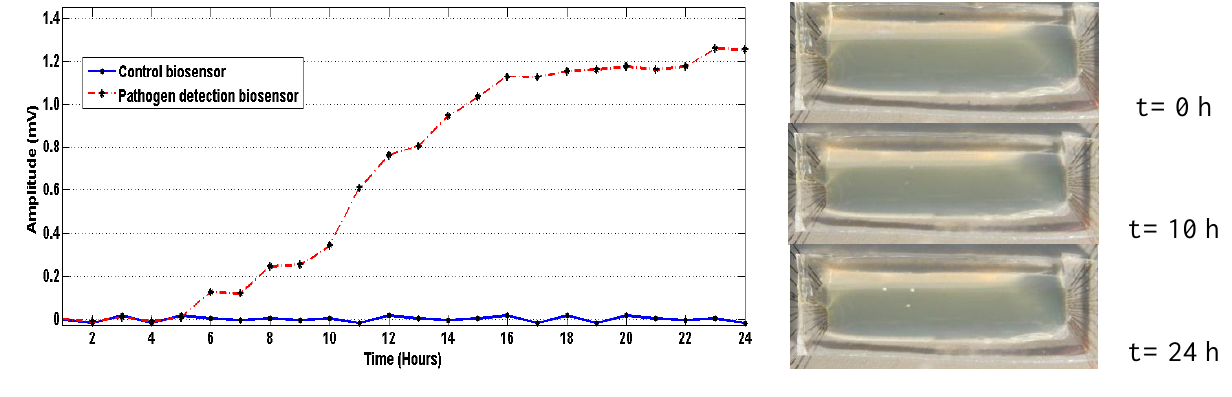
Figure 8. Signals from biosensor #7 on the test biochip underneath a bacterial colony and the same biosensor on the control chip. Pictures to the right show the growth of bacterial colony over